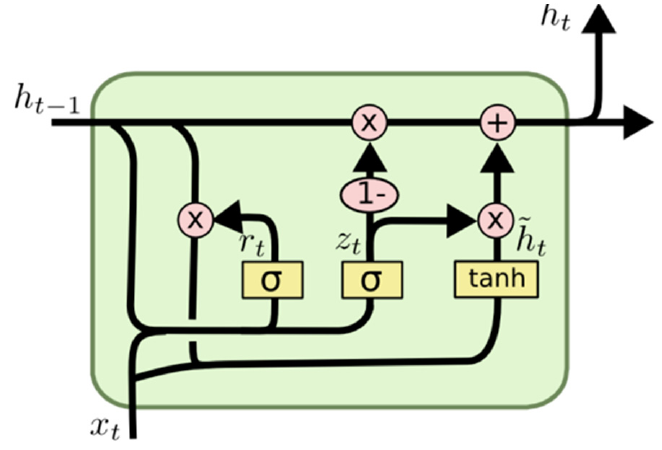
Figure 3. Basic structure of GRU.